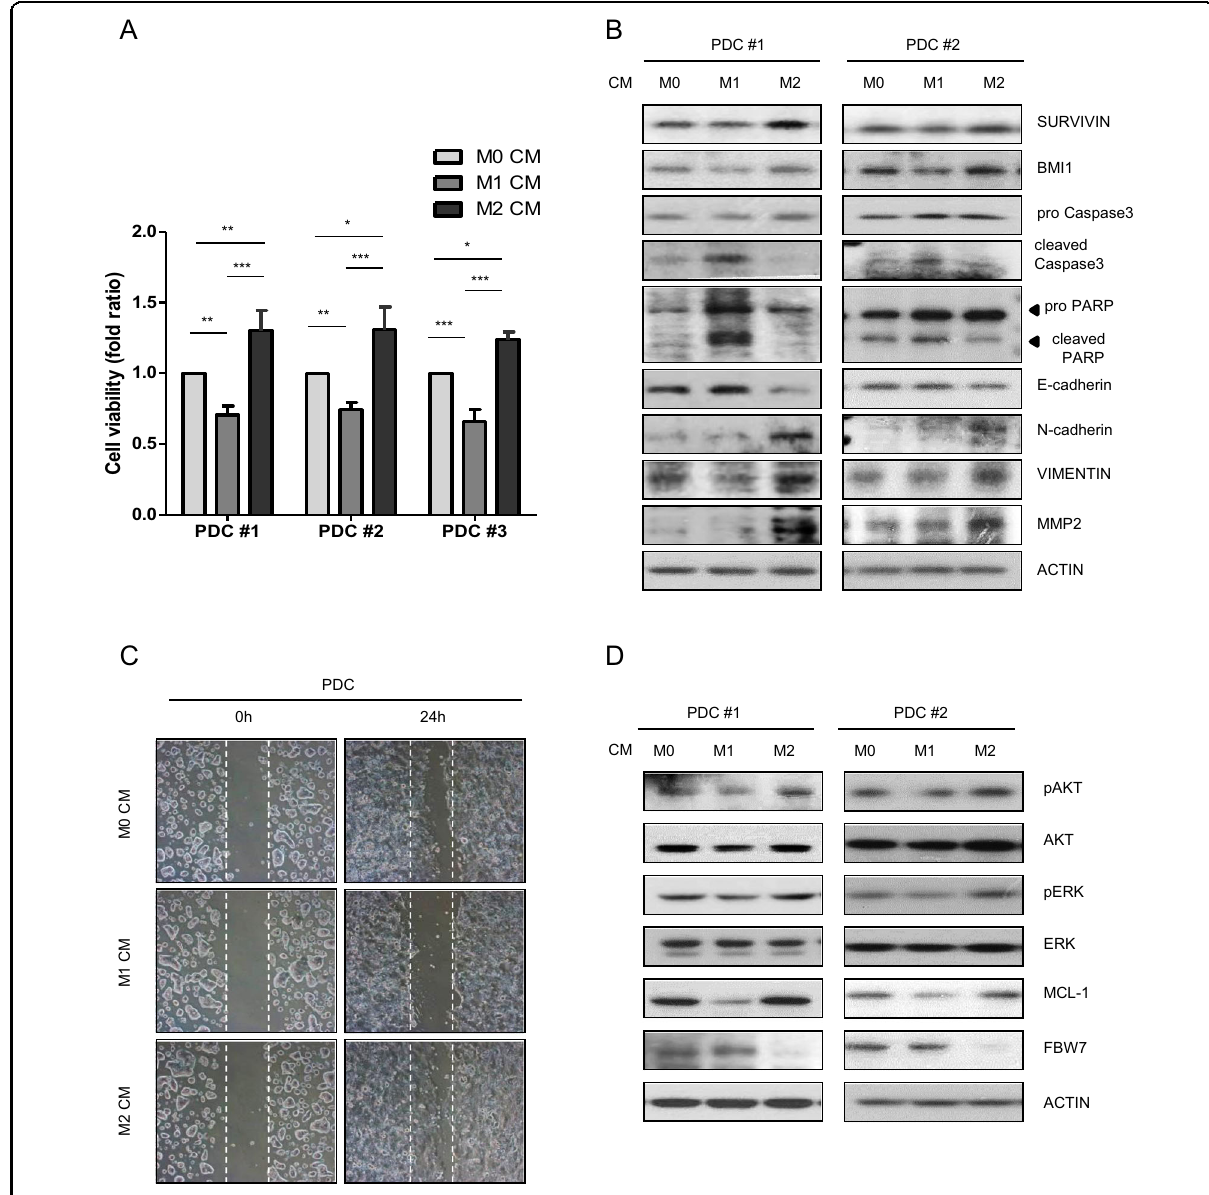
Fig. 5 Ex vivo analysis of the role of macrophage CM in colon cancer patient-derived cells (PDCs). a Estimation of PDC viability after coculture with macrophage CM for 24 h using the WST-1 assay. Error bars are derived from three independent experiments. b Expression levels of apoptosis and EMT markers in macrophage CM-treated PDCs were measured by western blotting. c Wound-healing ability was evaluated by creating wounds on a con fl uent monolayer of PDCs using 1-Dish 35-mm-high culture inserts. d Activation of AKT and ERK and expression levels of MCL-1 and FBW7 assessed by western blotting. Actin was used as a loading control. The results are presented as the mean ± SE. ** P < 0.01; *** P <